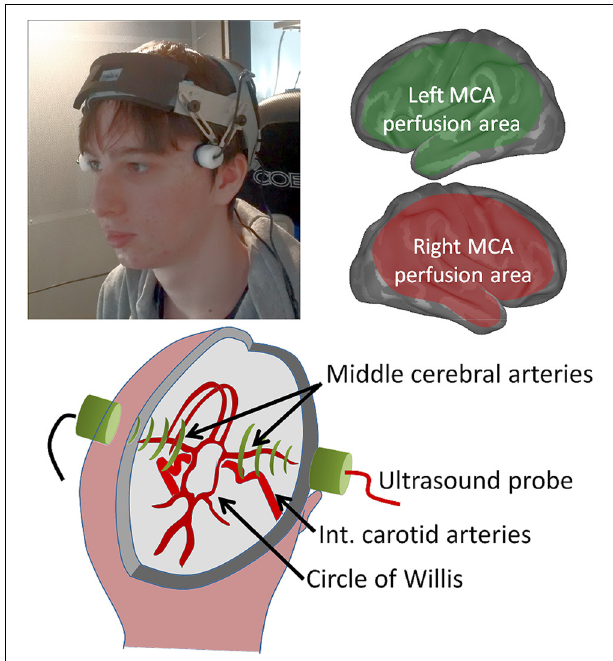
FIGURE 1 | Bilateral cerebral blood-flow is recorded using two small head-mounted probes (top left) that are relatively insensitive to participant motion. The middle cerebral arteries, insonated at a depth of ca 5cm as they emerge from the circle of Willis (lower schematic) supply extensive regions of the cerebral cortex (top right schematic), but this excludes frontal and sagittal areas, which are supplied by the anterior cerebral artery, and occipital and inferior temporal brain areas supplied by the posterior cerebral